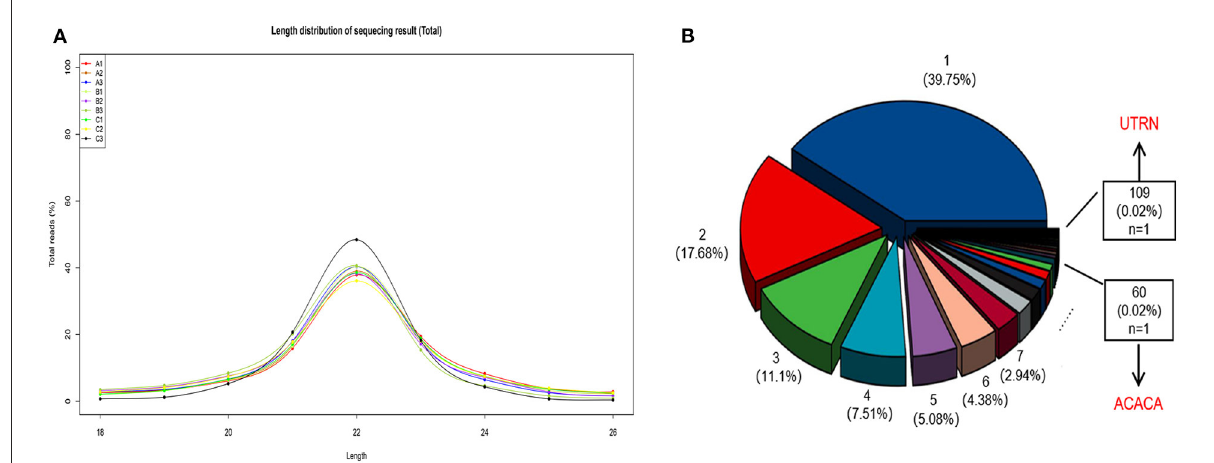
FIGURE1 (A) The length distribution of sequenced miRNAs. 6M: A1, A2, A3; 18M: B1, B2, B3; 30M: C1, C2, C3. (B) Percentage of circRNA host genes. For example, the blue pie chart shows that 39.75% of the genes are transcribed to form 1 circRNA, meanwhile the red pie chart shows that 17.68% of the genes can be transcribed to make 2 circRNAs, and so on.